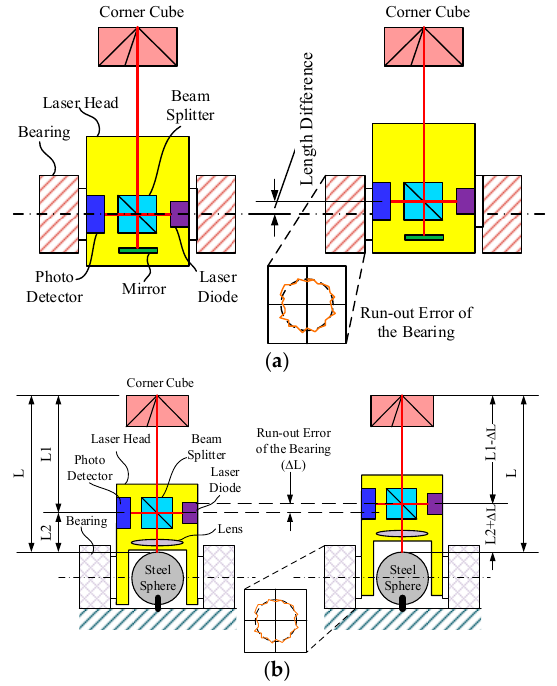
Figure 2. Illustration for optical path difference because of run-out error of bearing: ( a ) Laser Tracker uses a mirror to reflect the laser beam; and ( b ) LaserTRACER uses a steel sphere to reflect the laser